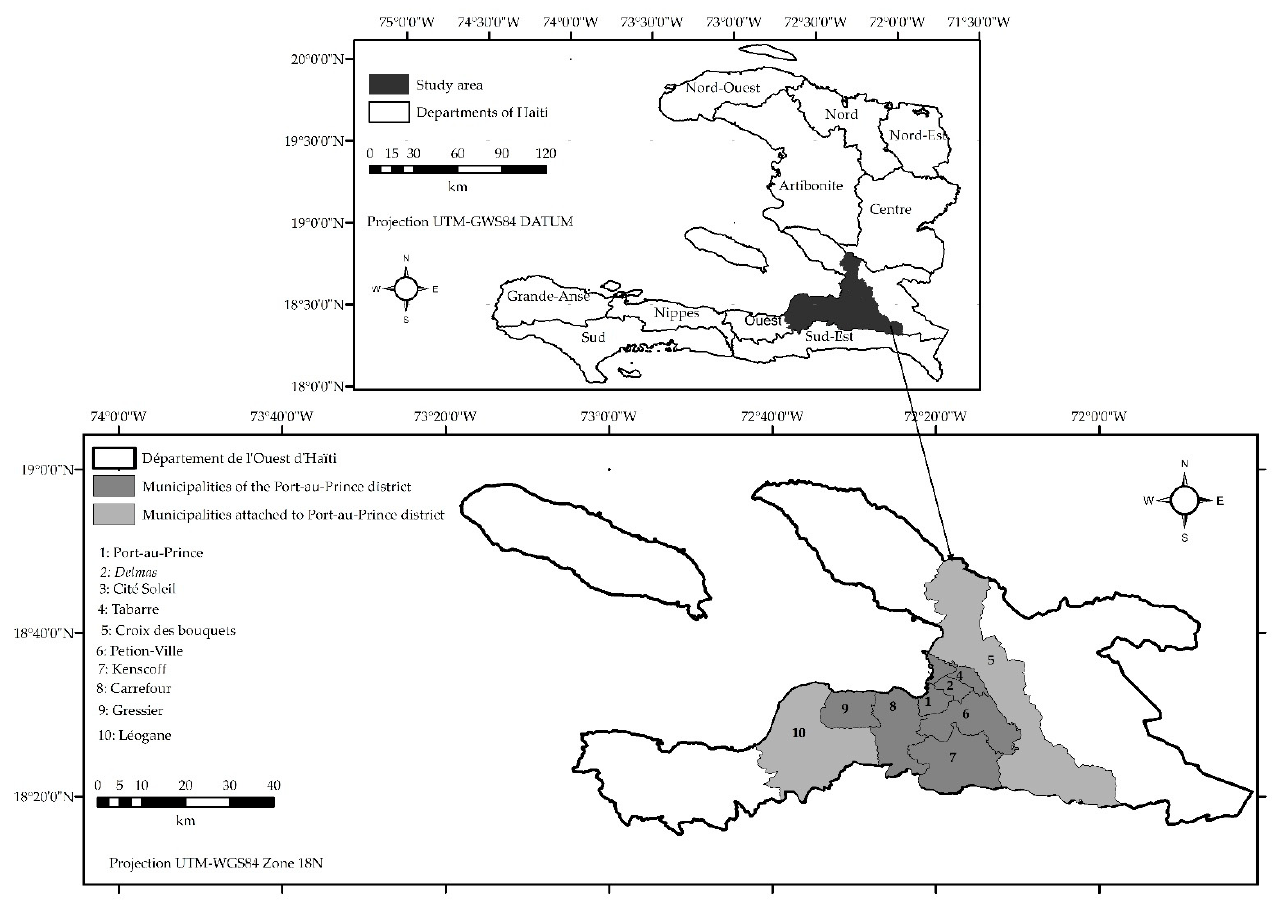
Figure 1. Geographical location of the municipalities of the Port-au-Prince district and attached municipalities in the western department of Haiti.